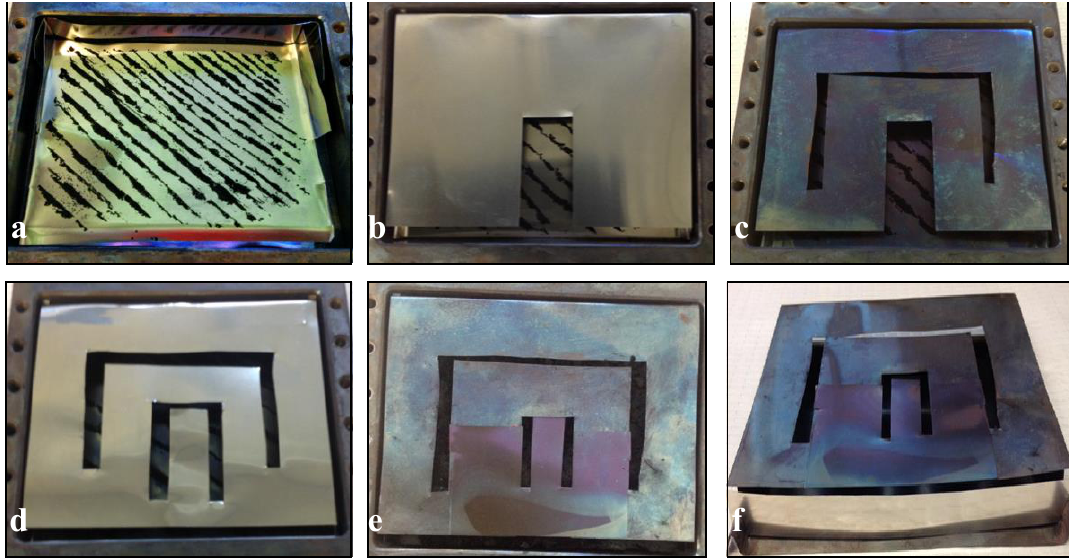
Figure 2. Evolution of the deflector design. Deflector design progression ( a – f ) was based on the experimental results and ANSYS models of gas distribution predictions.